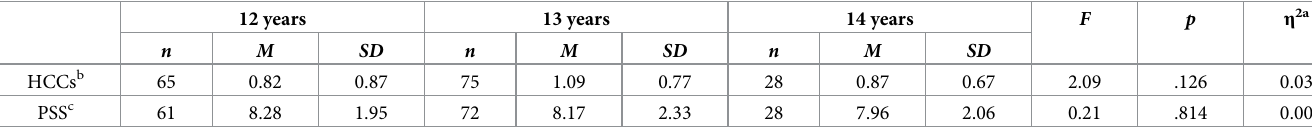
Table 4. Mean difference in physiological and perceived stress according to